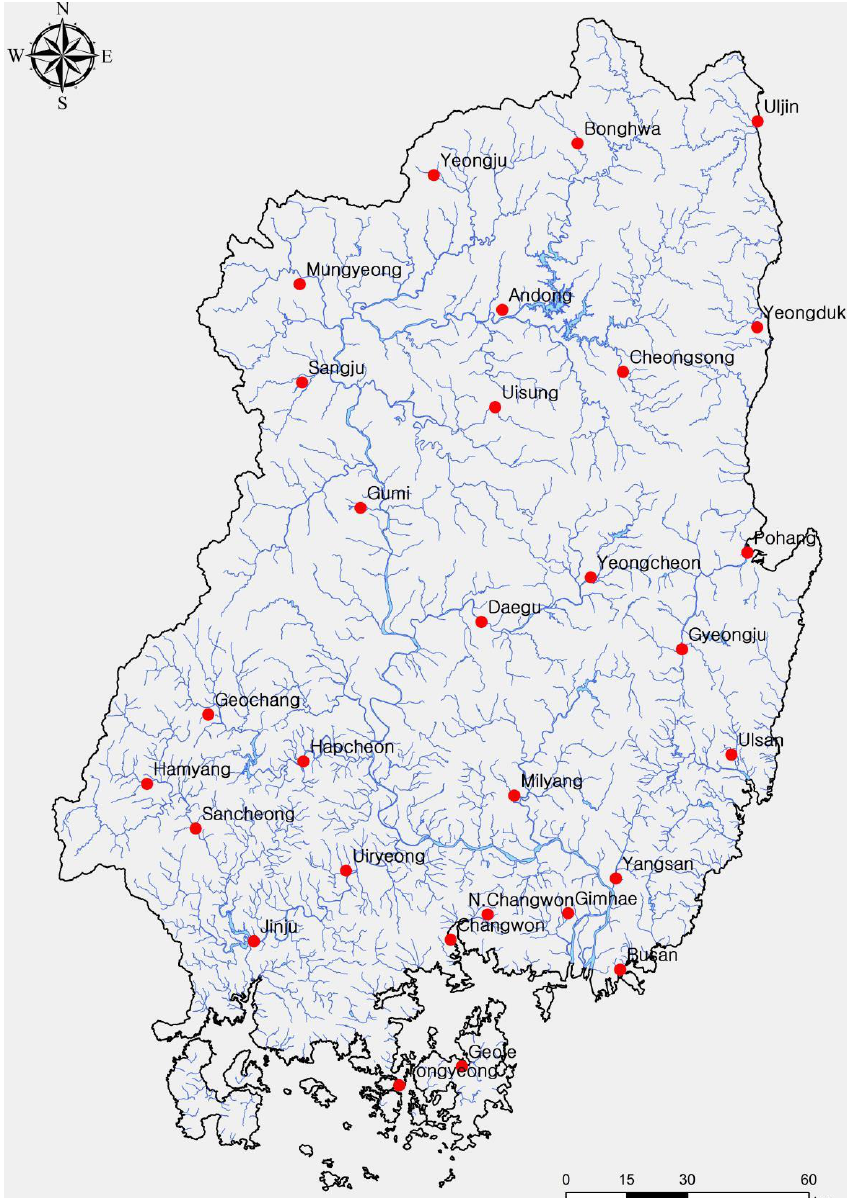
Figure 2. Location of the weather monitoring stations in the Nakdong River watershed [26].